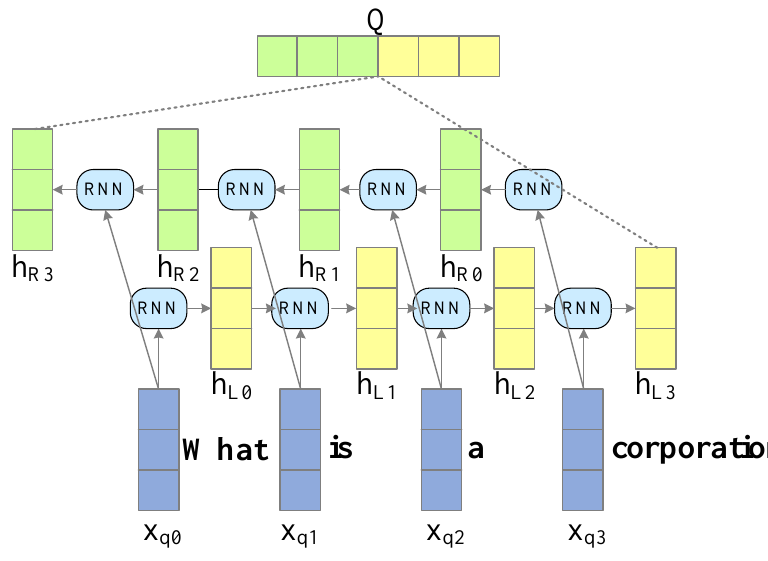
Figure 8. Sentence-level encoding for